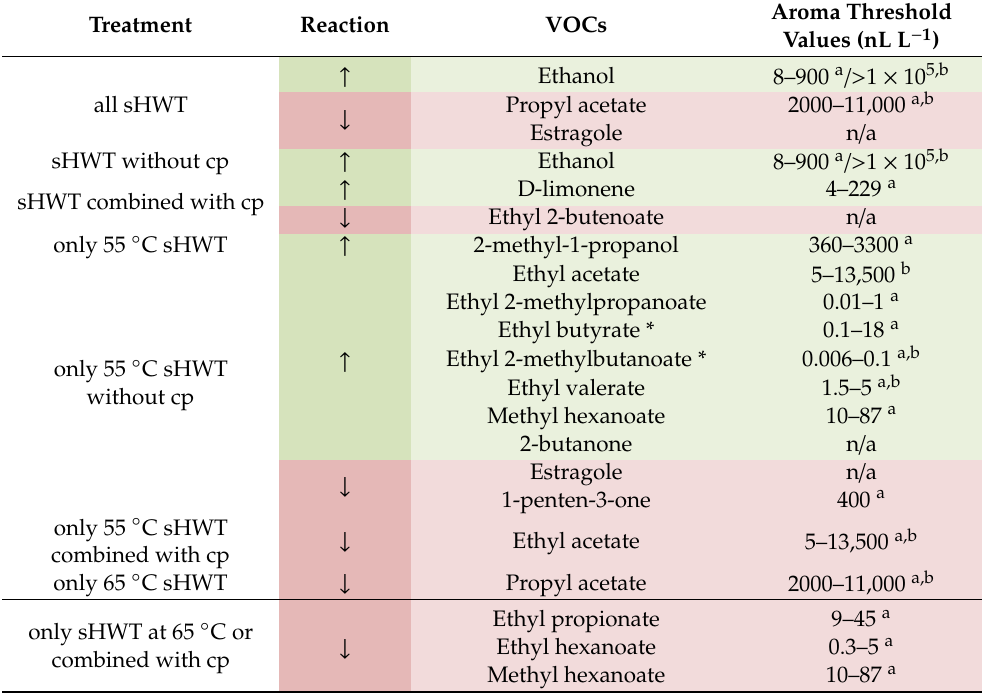
Table 3. Treatment-specific qualitative changes in the emissions of relevant VOCs and corresponding aroma threshold values of fresh-cut apple slices stored in sugar syrup at 4 ◦ C for up to 13